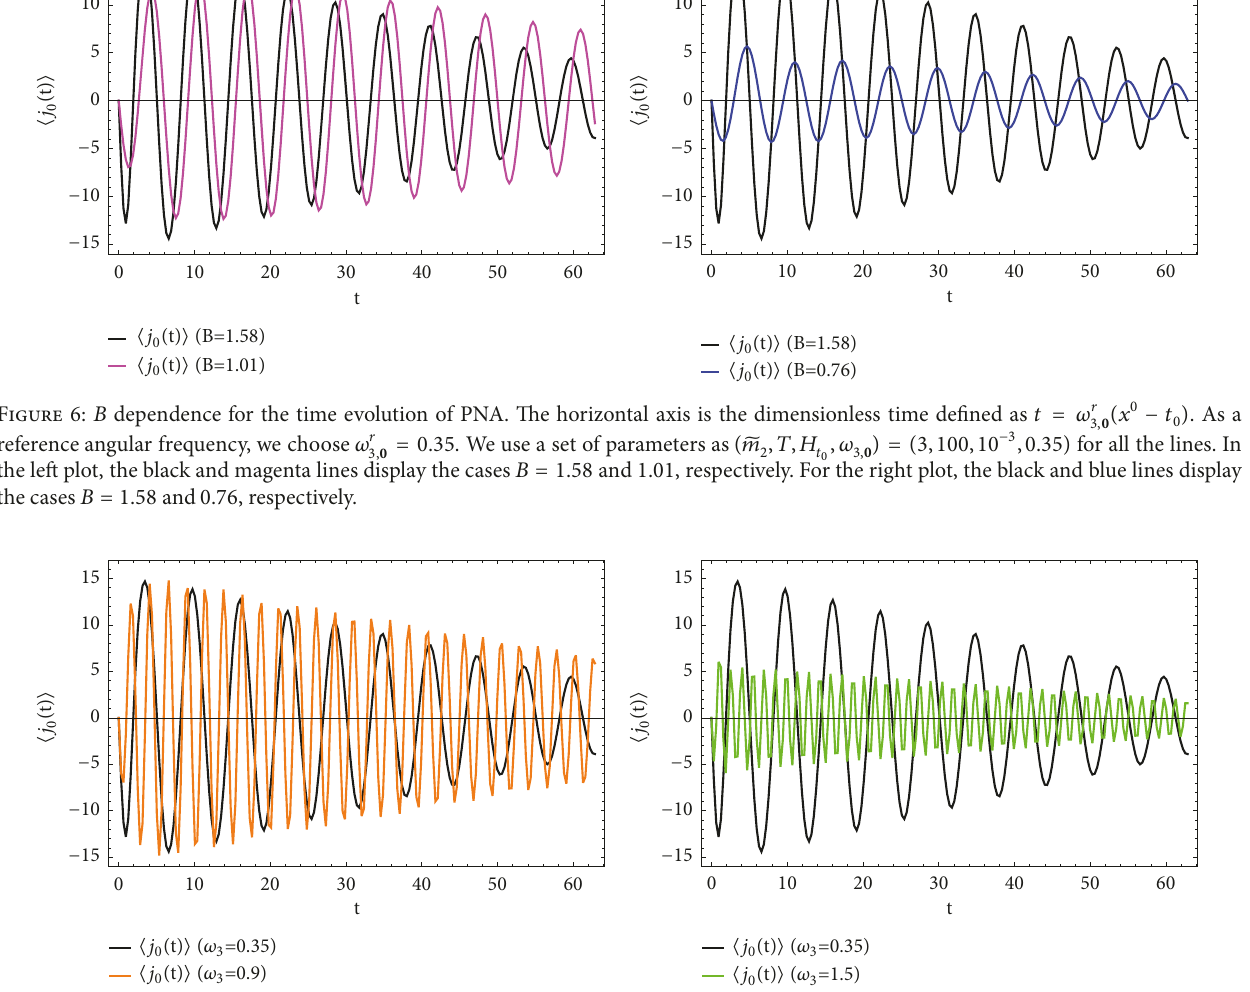
) = (2,3,1.58,100,10 −3 ) for all the lines. 0